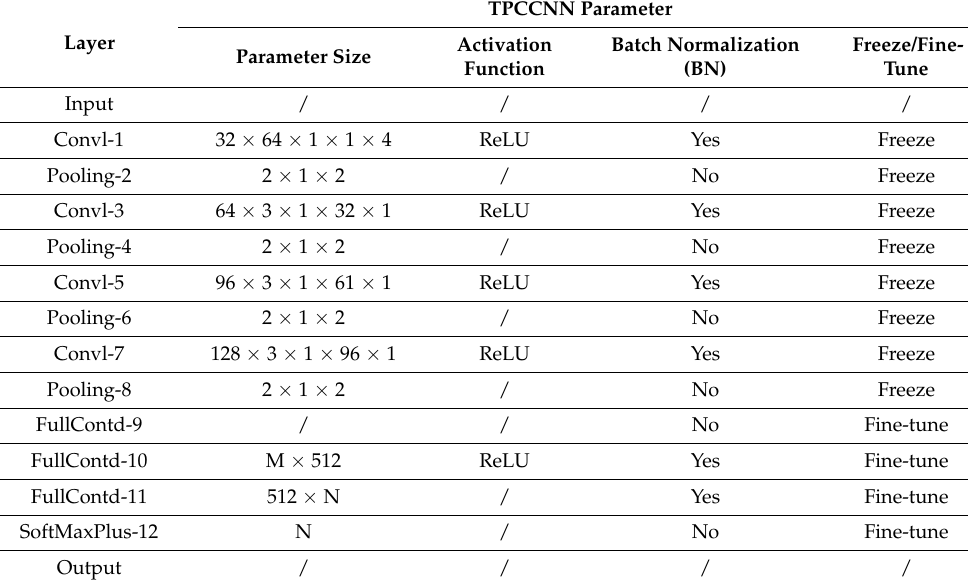
Table 1. Details of Structural Parameter of the TPCCNN